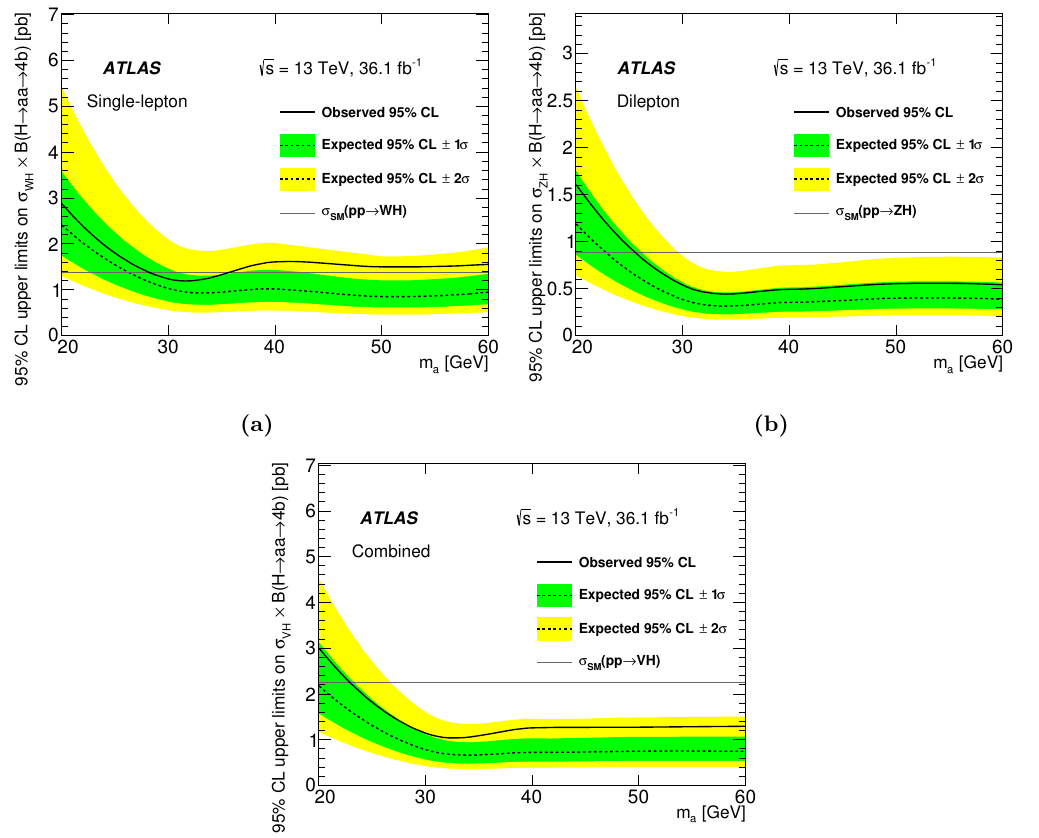
Figure 9. Summary of the 95% CL upper limits on (cid:27) channel and (b) the dilepton channel, and (c) the combination of both channels. The observed limits are shown, together with the expected limits (dotted black lines). In the case of the expected limits, one- and two-standard-deviation uncertainty bands are also